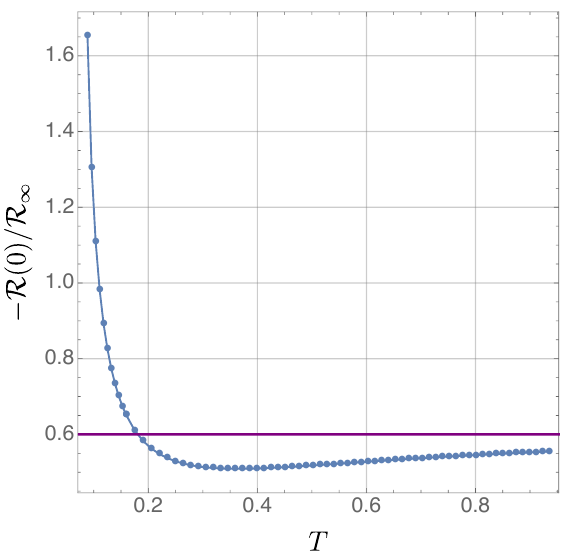
Figure 18 . Induced horizon curvature measured at the axis of rotation as a function of temper- ature computed for (cid:22) = 4 and (cid:23) = 3, with the horizontal purple line indicating the (cid:13)uid/gravity